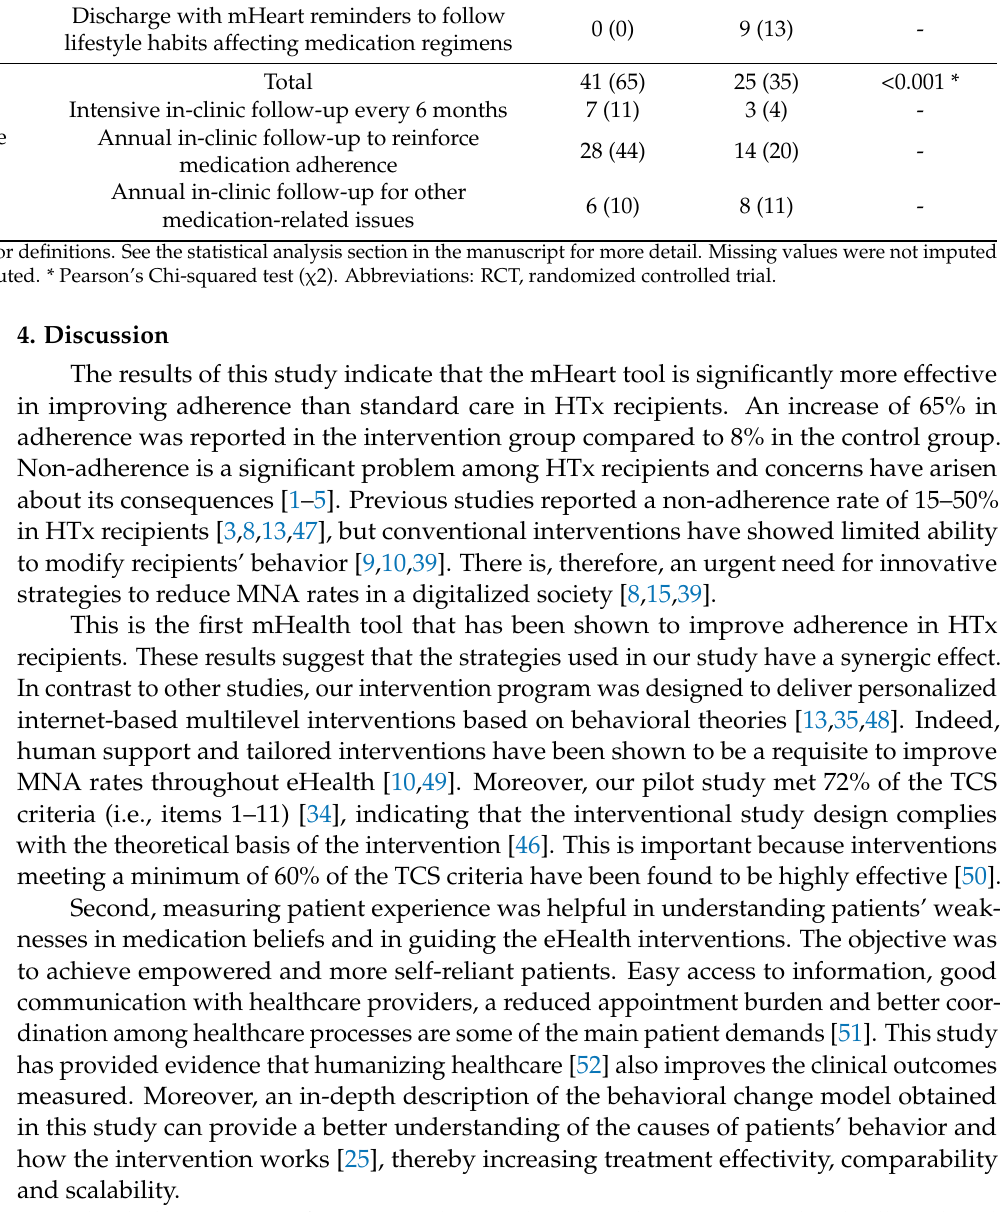
Table 2. Type of pharmaceutical care follow-up beyond the end of the study. Variables, N (%)